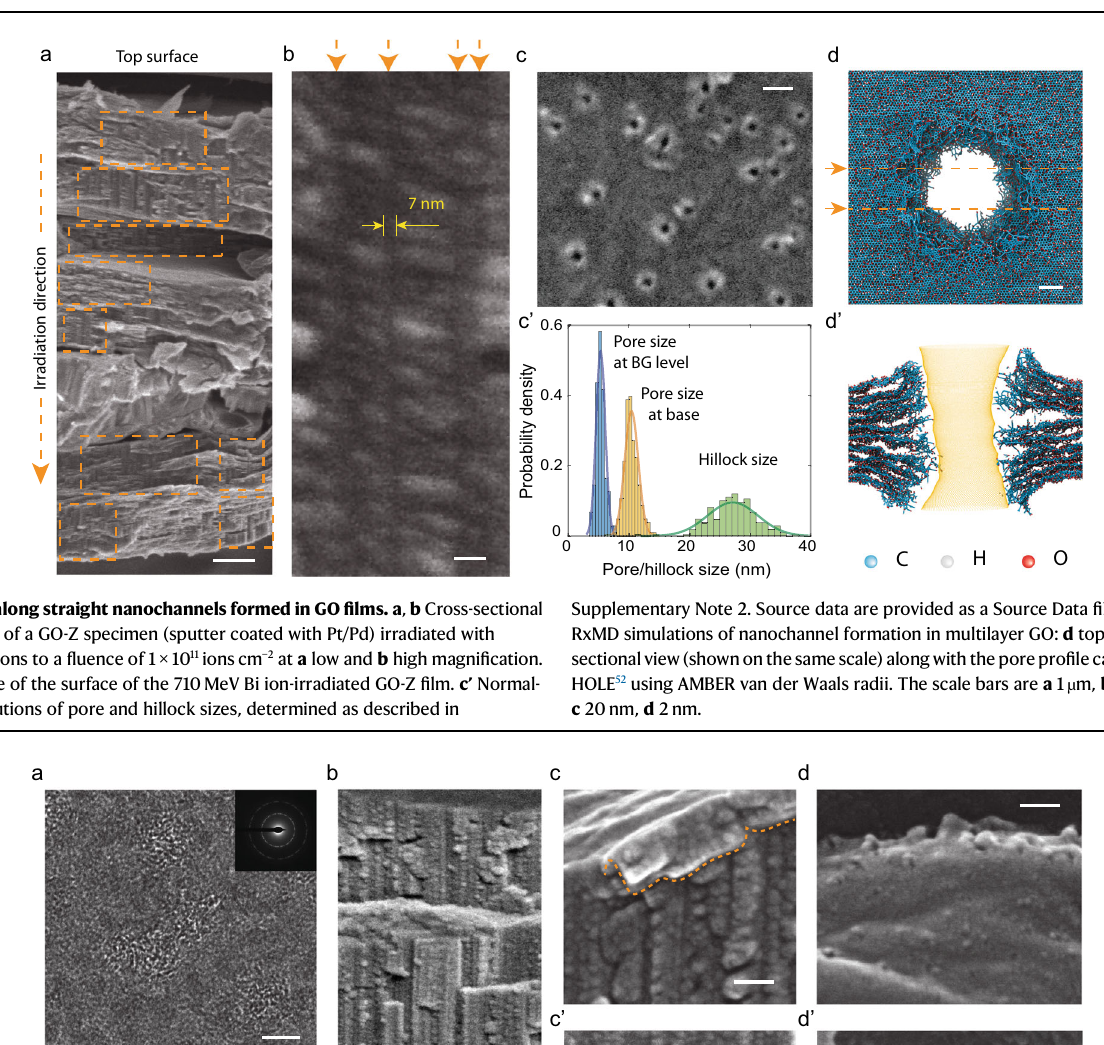
Fig. 3 | Patterning of GO with mid- to low-electronic-stopping-power ions. a TEM image of a suspended few-layer GO specimen irradiated with 167MeV Xe ions to a fl uence of 2×10 11 ionscm − 2 . b – d ’ SEM images of a GO-Z specimen deposited on a nylon-66 membrane and irradiated with 167MeV Xe ions to a fl u- ence of 6×10 11 ionscm − 2 (sputter coated with Pt/Pd) b , c Cross-sectional images at